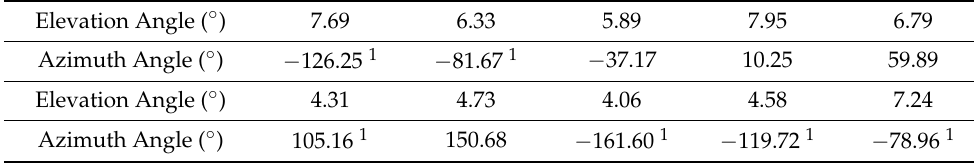
Table 6. DOA estimation by UCMA-ESPRIT for inner race fault signal at 290 rpm.